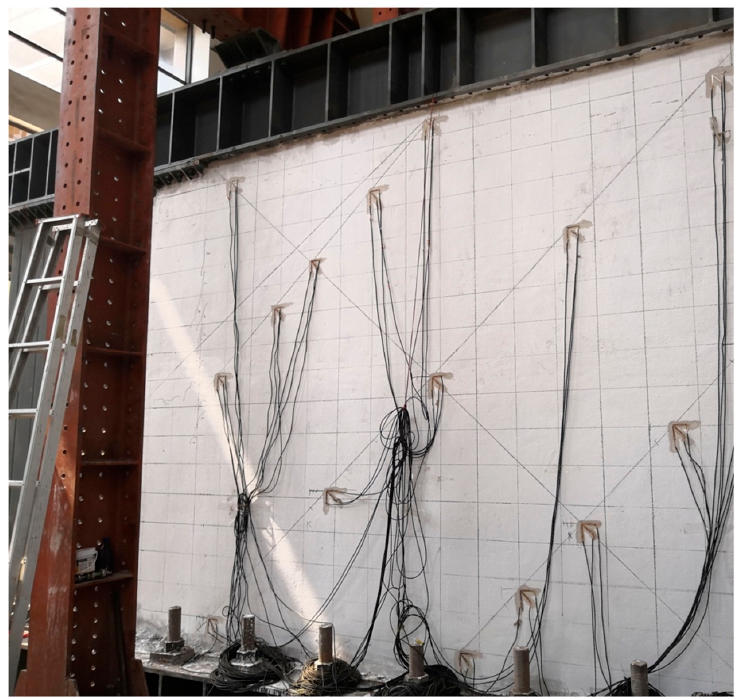
Figure 8. Diagram of specimen W2 in the experiment when the interface initially cracked and the horizontal displacement was 1.32 mm.